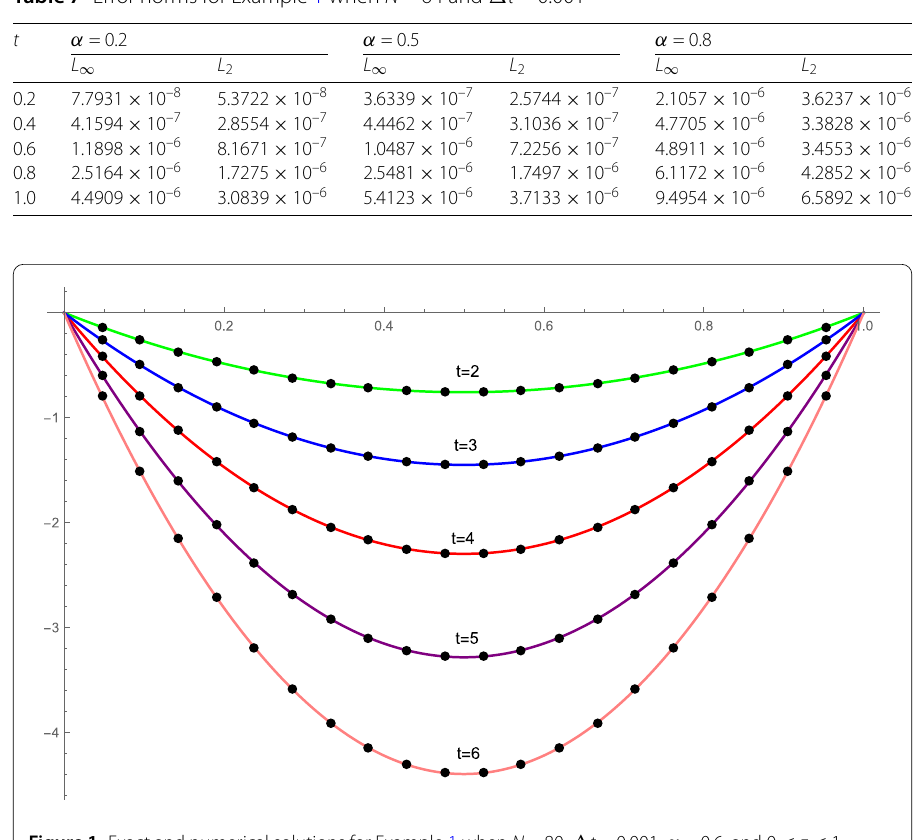
Figure 1 Exact and numerical solutions for Example 1 when N = 80, (cid:3) t = 0.001, α = 0.6, and 0 ≤ z ≤ 1